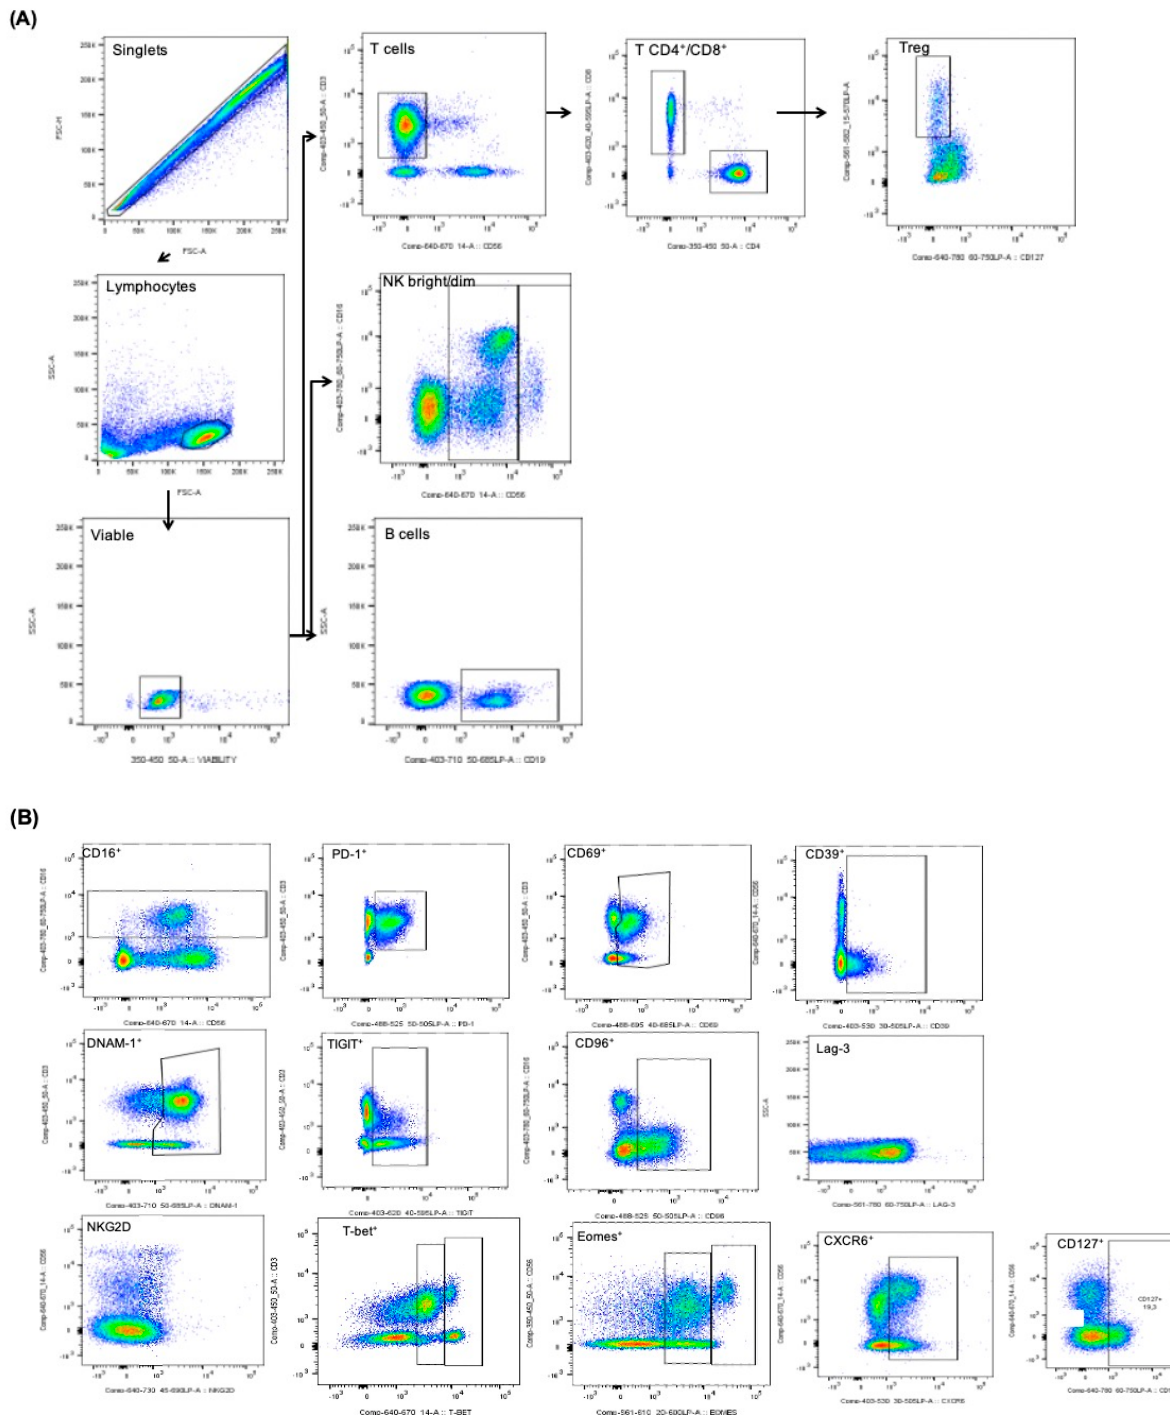
Figure 1. Lymphocytes gating strategy. ( A ) Flow chart depicting the order for subsetting the different lymphocyte populations. Events were initially gated on single events, then on lymphocytes by size and scatter. Living cells were gated next. From there, the different populations were gated based on their markers. ( B ) Gating strategy for the different lymphocyte immune checkpoints. Representative examples for the gatings of the different checkpoints used in the study. LAG-3 and NKG2D could not be gated and were analyzed by MFI quantification instead. T CD4 + : T helper cells, T CD8 + : cytotoxic T cells, NK: Natural Killer cells, Treg: regulatory T cells.